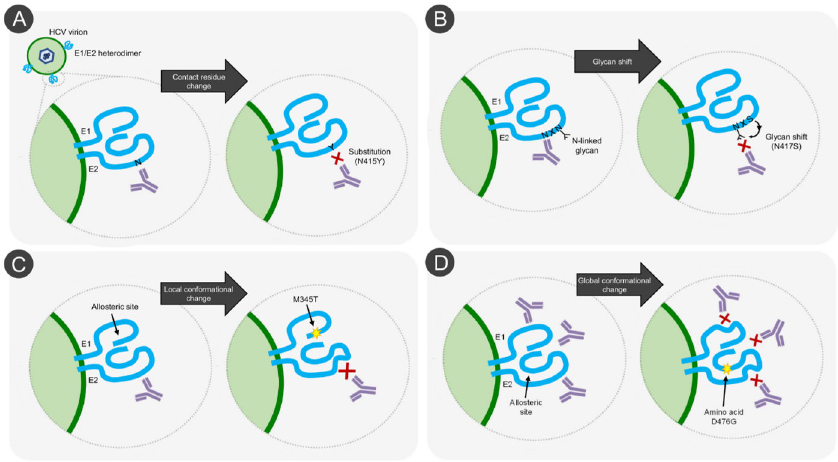
Figure 3. Mechanisms of direct HCV escape from neutralizing antibodies. ( A ) Contact residue change. Substitutions that directly alter a contact residue, whereby antibody–antigen affinity is reduced. ( B ) Glycan shift. Altered glycosylation can lead to HCV resistance to NAbs. The glycan masks the broadly neutralizing epitope on the viral glycoproteins, thus preventing neutralization of the viral particle. ( C ) Local allosteric change. Substitutions at positions not directly within the epitope can alter HCV sensitivity to a specific NAb by inducing local allosteric changes that alter specific NAb epitope accessibility. ( D ) Global allosteric change. Substitutions at positions not directly within the epitope can alter HCV sensitivity to a wide range of NAbs by inducing global allosteric changes that alter NAb epitope accessibility.